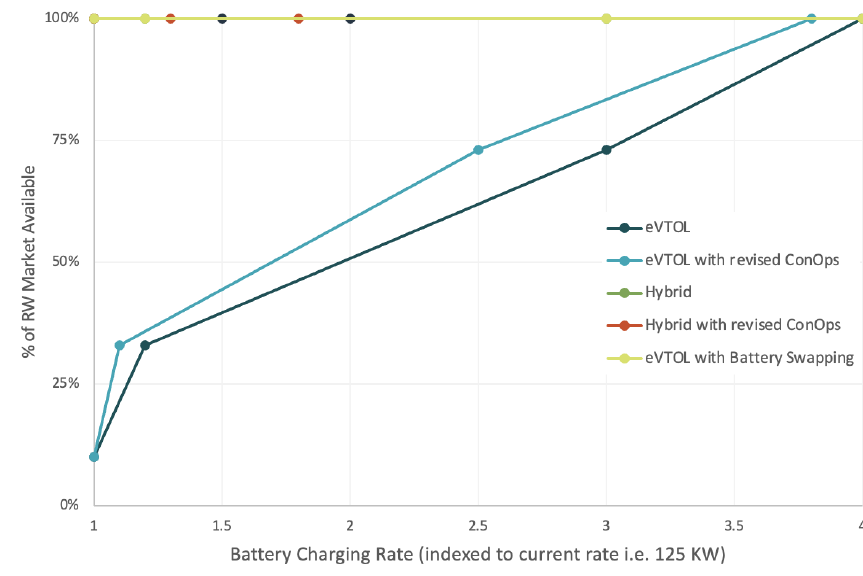
Figure 11. Impact of fast charging on eVTOLs ability to capture rotary-wing market share.